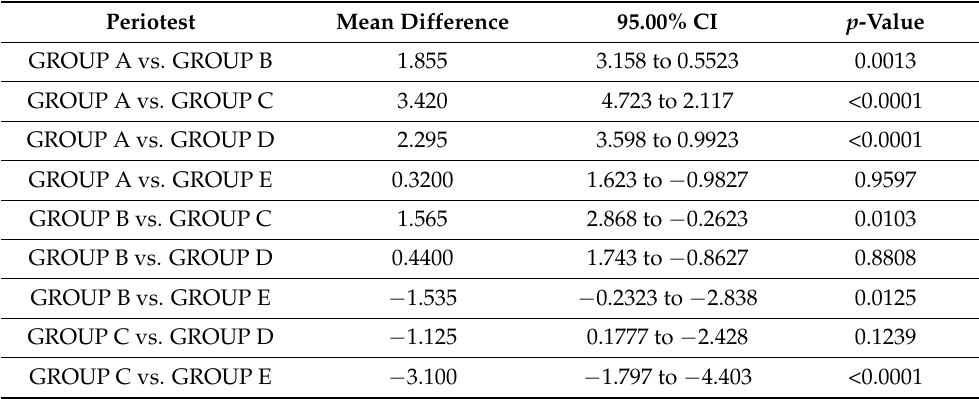
Table 4. Periotest comparison between the study groups (ANOVA, Sidak post hoc